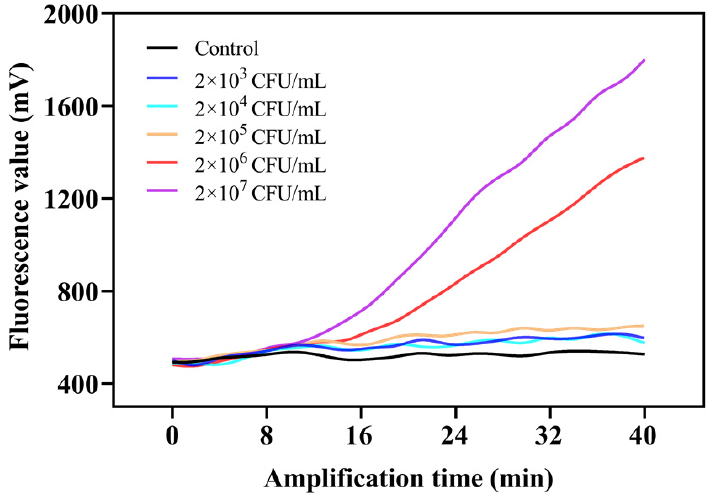
Figure 4. The LOD for viable Salmonella in pure culture by the TOMA–RAA method.